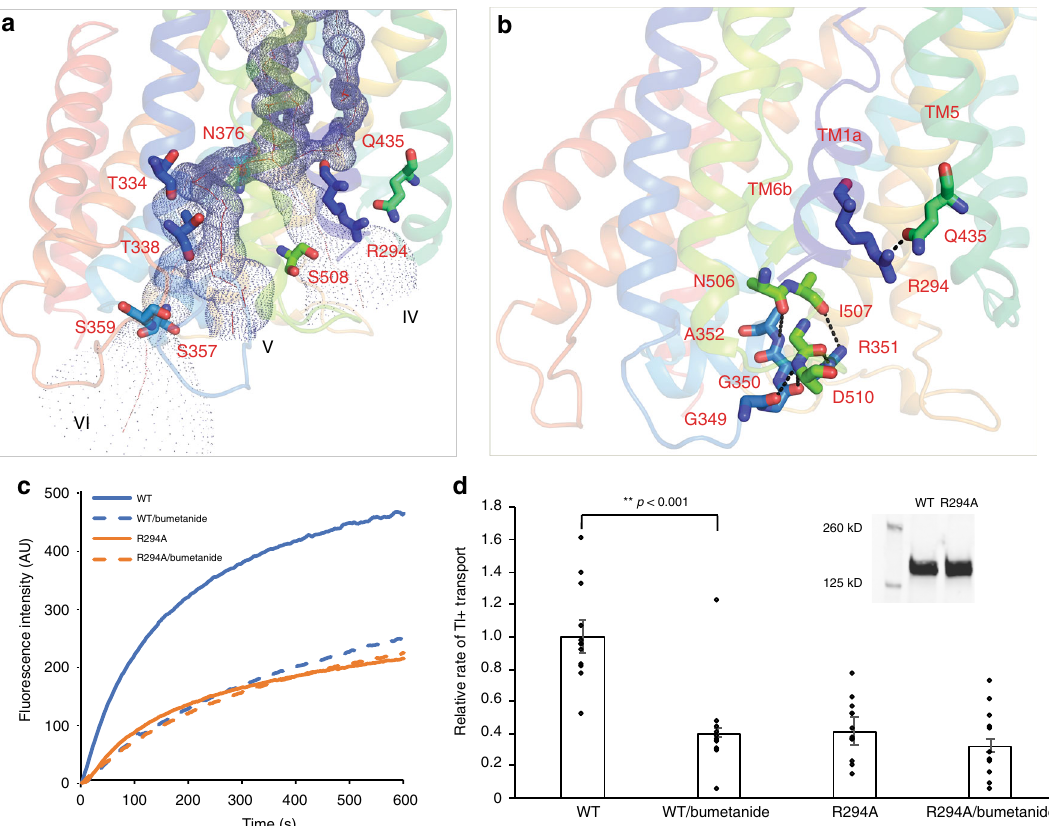
Fig. 6 Intracellular vestibules and interactions stabilizing inward-open conformation. a Hydrophilic residues lining the intracellular exits are shown in sticks. b Residues that participate in stabilizing inward-open conformation are shown in sticks. Interactions are denoted with black dashed lines. c Kinetics of transport were measured for the WT NKCC1 and R294A mutant using Tl + ion fl ux assay. d Rates of transport were all normalized to that measured for the WT NKCC1 without inhibition by bumetanide. Each circle represents a kinetic measurement of a single sample and error bars represent s.e.m. The R294A mutant shows no statistically signi fi cant bumetanide-sensitive transport. The inset shows that the WT NKCC1 and R294A mutant exhibited similar expression level as determined by western